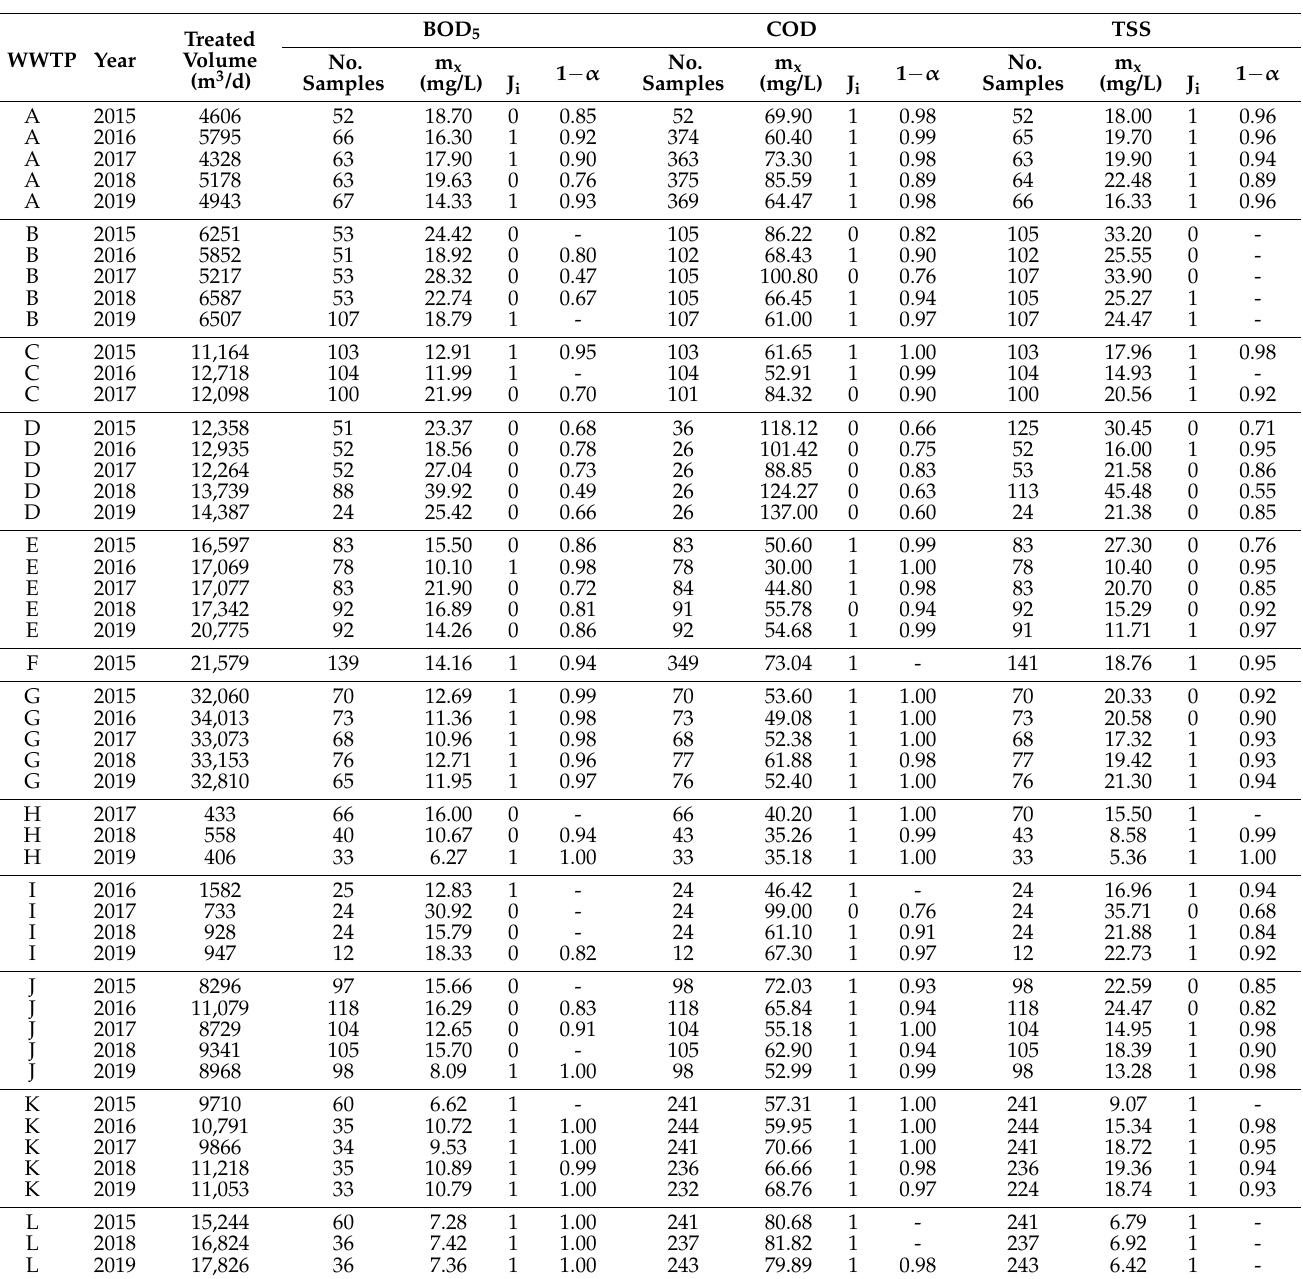
Table 2. WWTP reliability and compliance (J i ) for BOD 5 , COD, and TSS (“-“data do not fit a lognormal